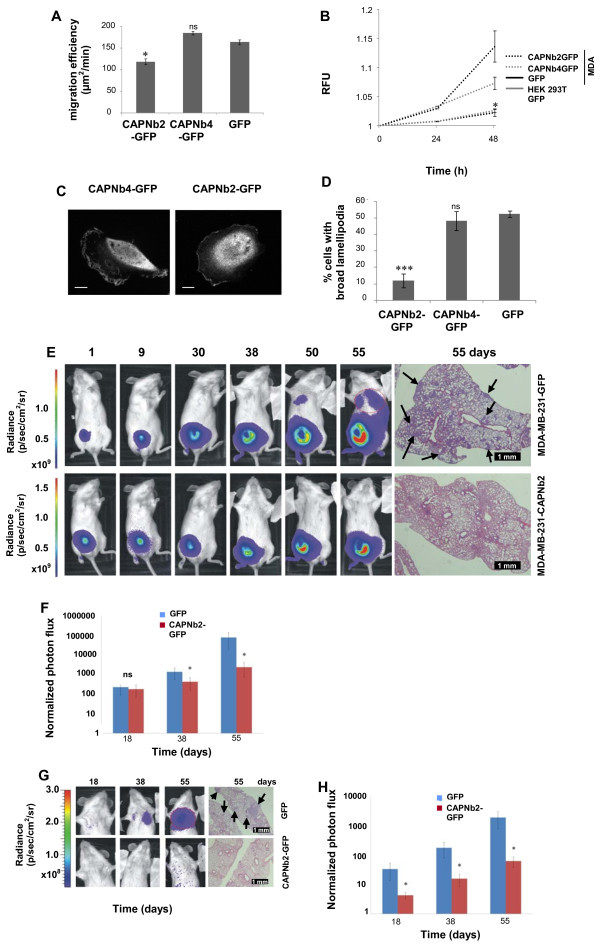
CAPNb2 restrains lung metastasis of breast cancer cells. (A)In vitro cell migration. CAPNb2 significantly reduces migration of MDA-MB 231 cells; n = 6 (CAPNb2), 7 (CAPNb4) and 7 (GFP), P = 0.017 CAPNb2 versus GFP. Ns, not significant. (B) Matrigel invasion. MDA-MB-231 cells stably expressing CAPNb2 are not invasive compared with GFP-transduced cells (t test, P = 0.046; n = 3). RFU, relative fluorescence unit. (C, D) MDA-MB-231-CAPNb2-EGFP cells display fewer broad lamellipodia (t test, P = 0.00013; n = 3). (E) Orthotopic metastasis model. Noninvasive bioluminescence images of mice injected with GFP control cells or CAPNb2 cells. A red line (55d) marks the region of interest. H/E stainings of lung sections are at right. Arrows, macrometastases. (F) Normalized photon-flux profile from lungs at the indicated times in the orthotopic metastasis model. t38P = 0.0240; t55P = 0.0339; n = 6 to 7. (G) Tail-vein metastasis model. Bioluminescence images of mice injected with GFP control cells or CAPNb2 cells. A red line (55d) marks the region of interest. H/E stainings of lung sections are at right. Arrows, macrometastases. (H) Normalized photon-flux profile from lungs at the indicated times in the tail-vein metastasis model. t18P = 0.0204; t38P = 0.0092; t55P = 0.0104; n = 7. A mouse in the GFP cohort (n = 4) with an unusually high normalized photon flux of 2.93 × 107 photons/s was excluded. The total photons/s was measured in a standard-sized circular region of interest encompassing the murine chest. For normalization, we set to 1 the average photon flux at day 0 of the lungs of mice injected with CAPNb2-GFP cells. Error bars represent mean ± SEM except for D, in which mean ± SD are shown. *P < 0.05; ***P < 0.001.